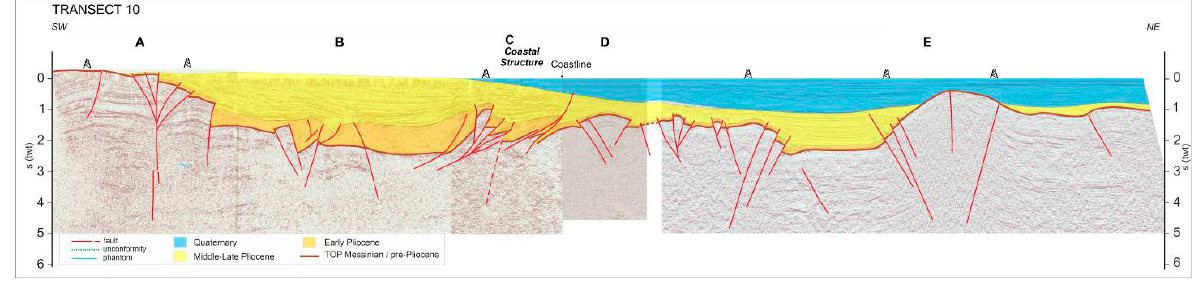
Figure 6. Transect 10.